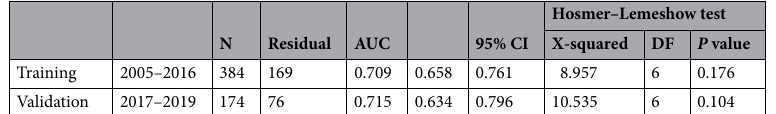
N Residual AUC 95%